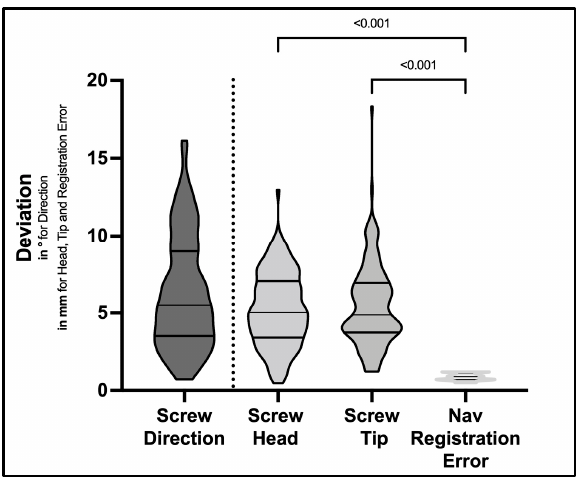
Figure 4. Deviation of final screw positions to preplanned screw trajectories illustrated in violin plots. Results are presented as angular deviation (in degrees) between screws for screw direction and mean absolute distances (in mm) between screw head and screw tip points. Differences for head and tip points were statistically significant in relation to navigation registration error recorded during surgery, respectively (ANOVA p < 0.001).